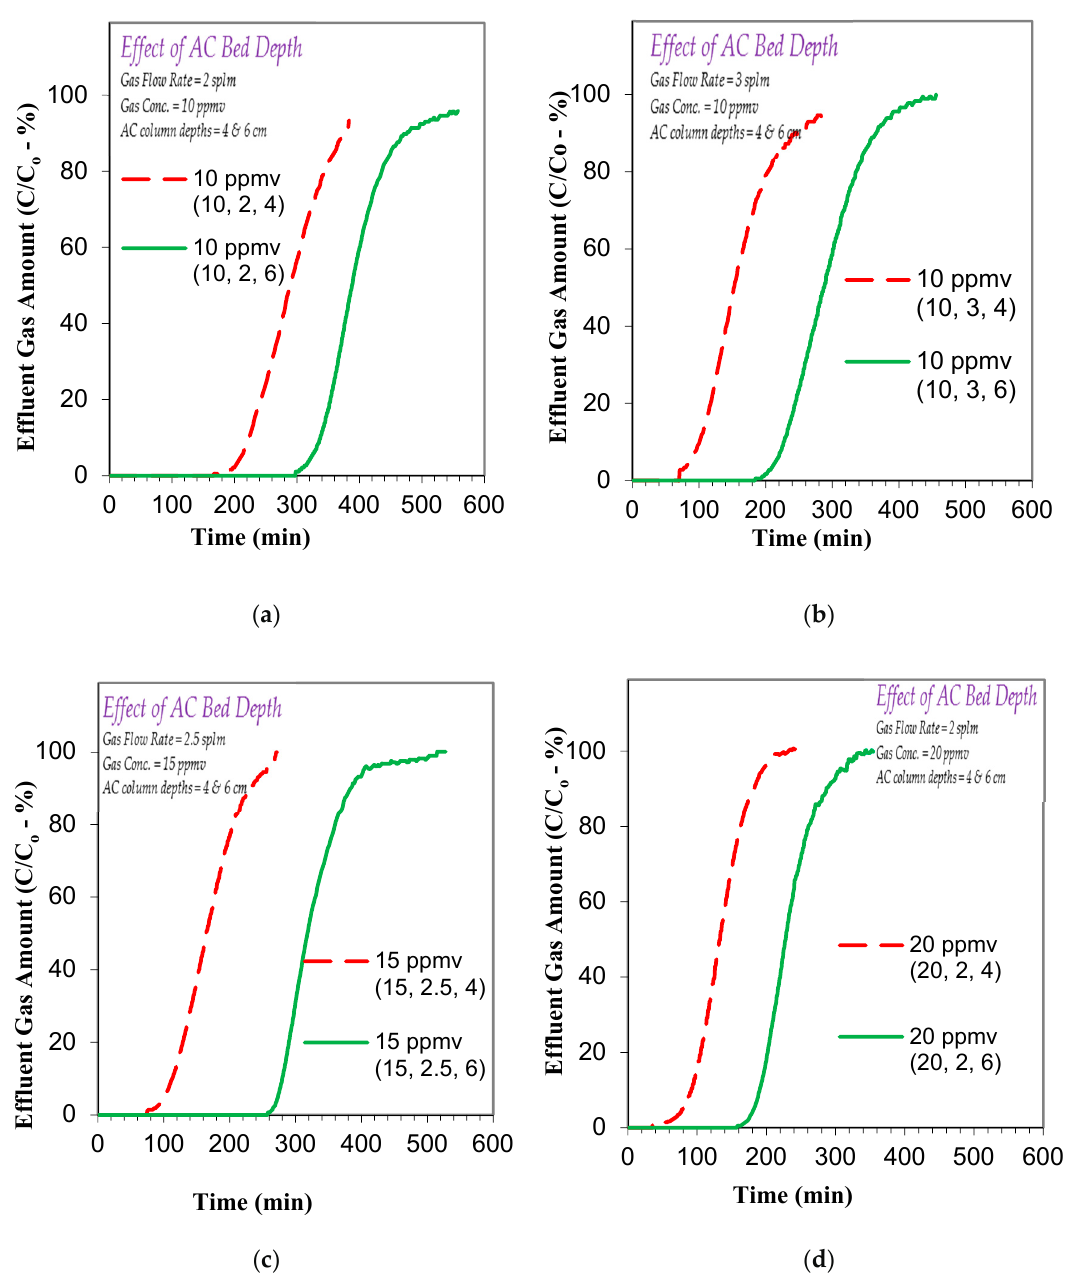
Figure 5. Effect of AC column length on the adsorption breakthrough curve profile of toluene/C 6 H 5 CH 3 gas on to AC produced from date palm branches ( a ) toluene/C 6 H 5 CH 3 gas flow rate flow rate = 2 slpm; influent gas concentration 10 ppmv; AC column lengths = 4 and 6 cm; ( b ) toluene/C 6 H 5 CH 3 gas flow rate flow rates = 3 slpm; influent gas concentrations 10 ppmv; AC column lengths = 4 and 6 cm; ( c ) toluene/C 6 H 5 CH 3 gas flow rate flow rate = 2.5 slpm; influent gas concentration 15 ppmv; AC column lengths = 4 and 6 cm; ( d ) toluene/C 6 H 5 CH 3 gas flow rate flow rate = 2 slpm; influent gas concentration = 20 ppmv; AC column lengths = 4 and 6 cm; (AC SSA BET = 800.87 m 2 /g and average pore width = 30.32 Å; AC bed dia. 6.35 mm).